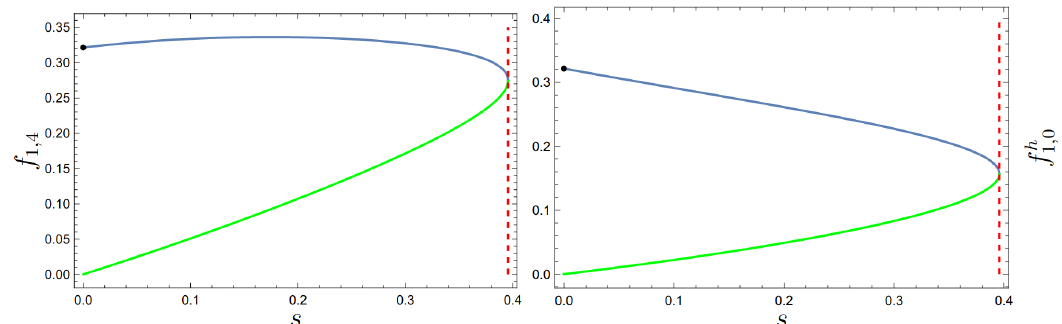
Figure 5 . Coefficients { f 1 , 4 , f h } , see (3.44) and (3.45), of the perturbative conformal order in 1 , 0 b → + ∞ deformation of Model II, with a parameter s characterizing the cubic coupling between the scalars f and g , see (3.43). The black dot indicates s = 0 results reported in appendix A. There are two branches of the conformal order for s < s , represented by the vertical dashed red lines. max Since s 1 , there is no perturbative conformal order in Model II. max <